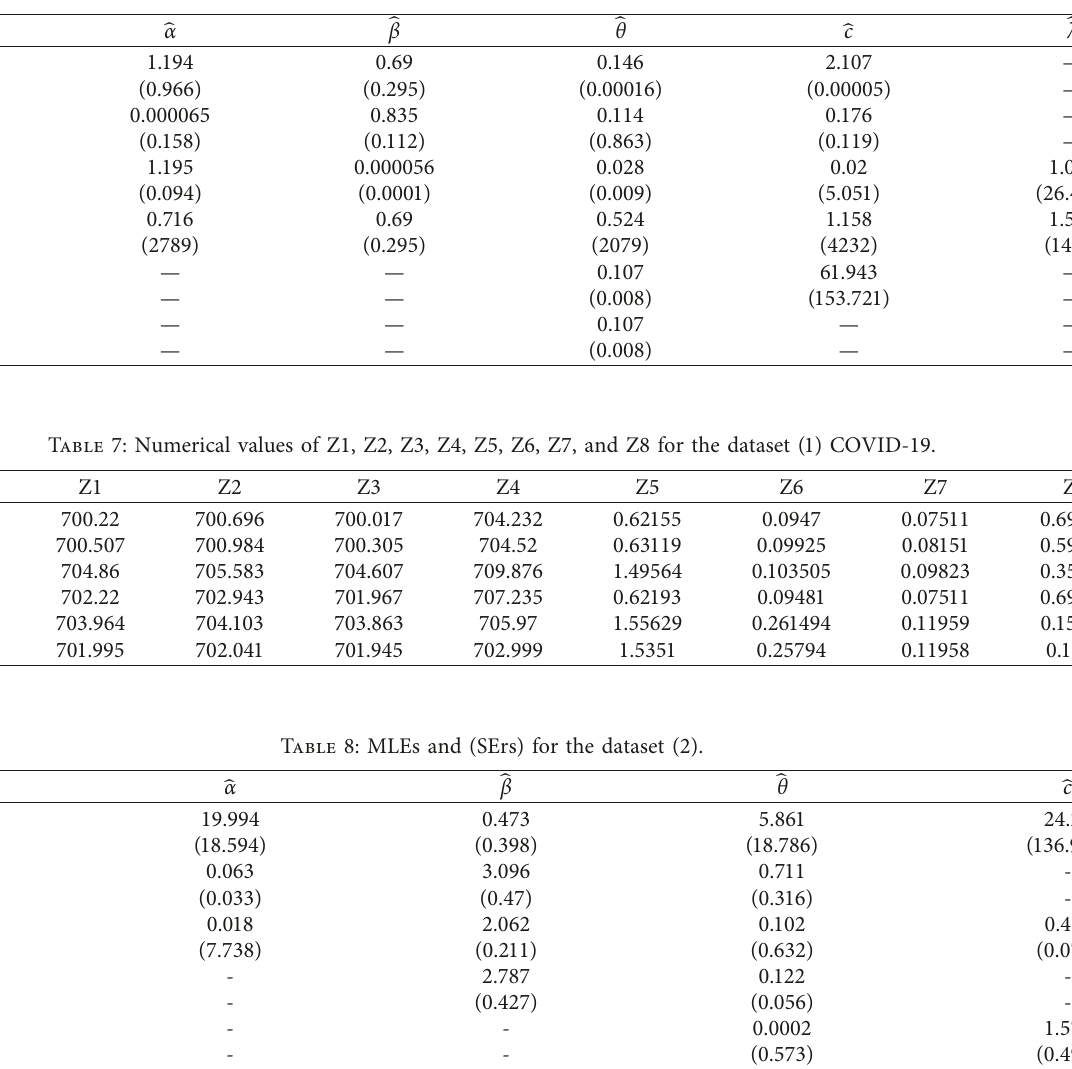
Table 6: MLEs and (SErs) for the dataset (1) COVID-19.